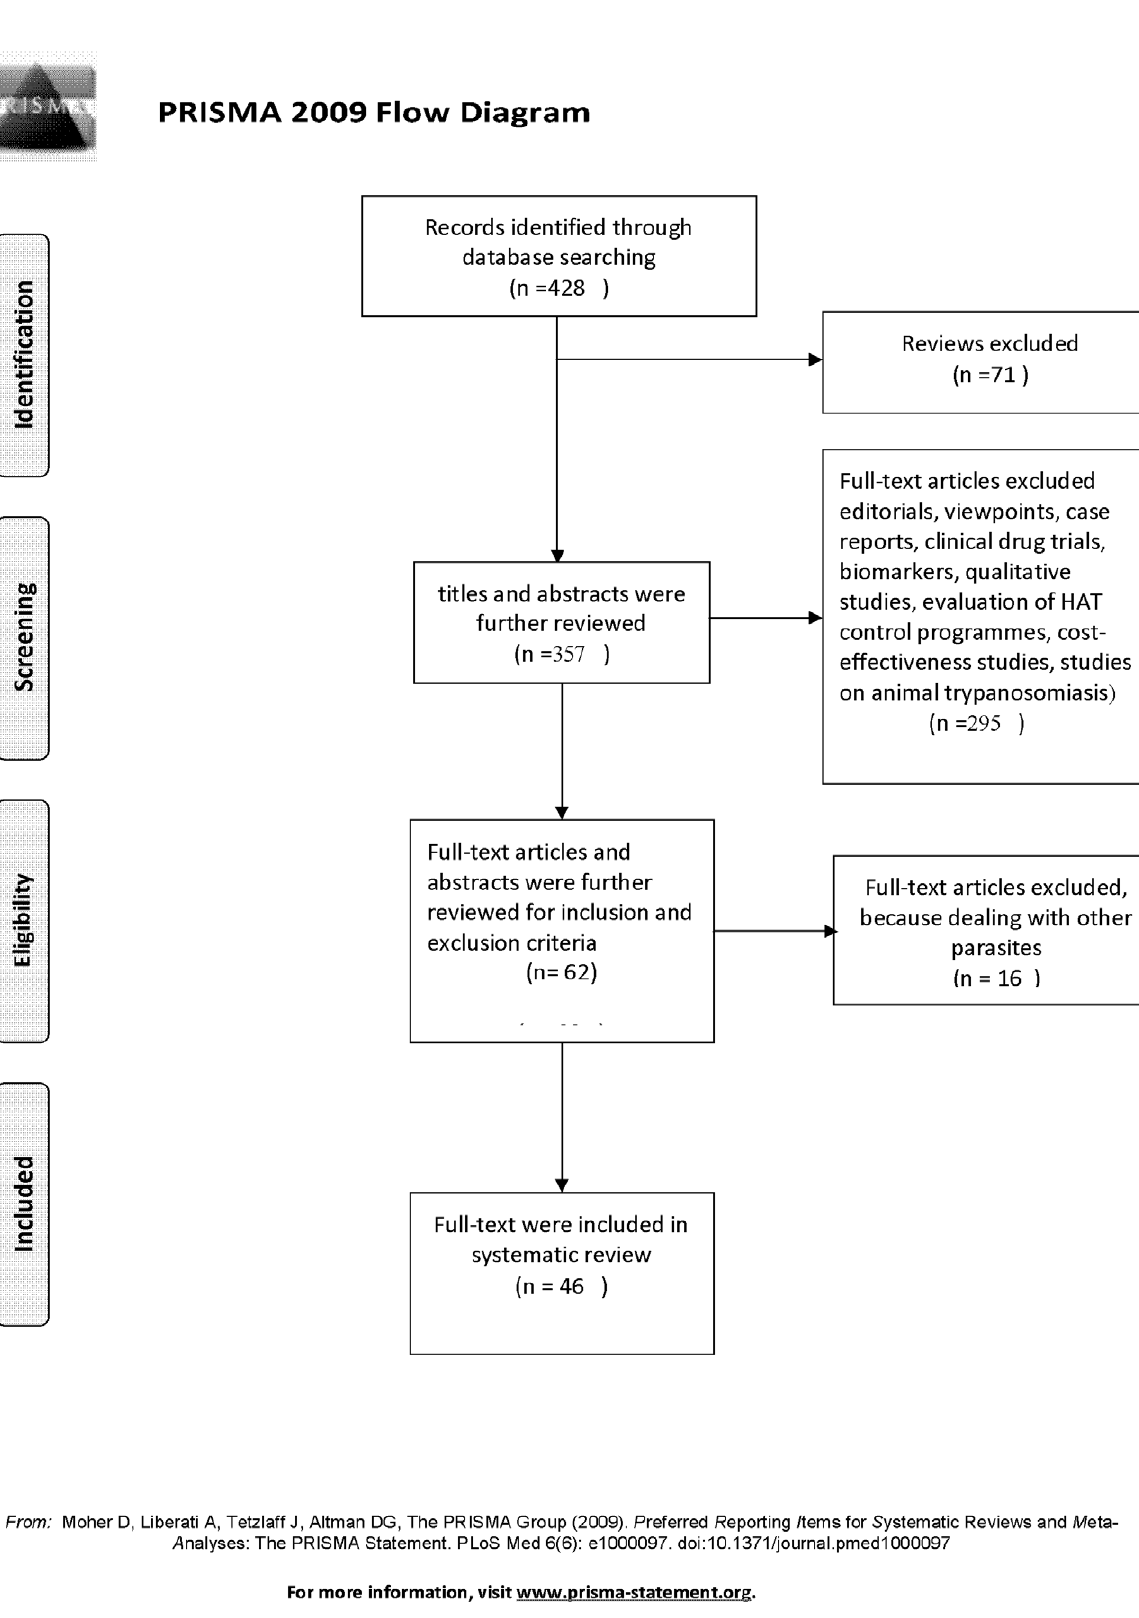
PLOS Neglected Tropical Diseases |